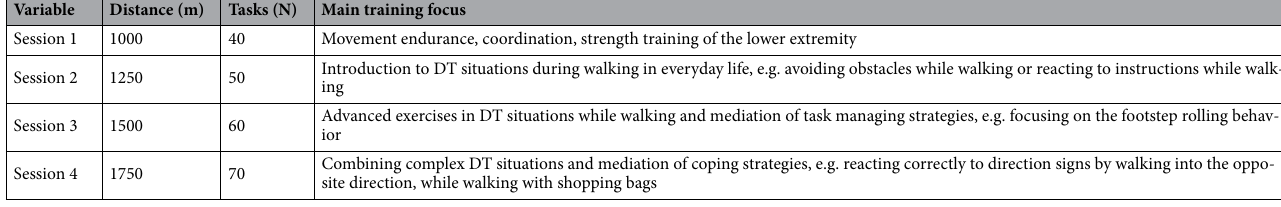
Table 1. Main content of the